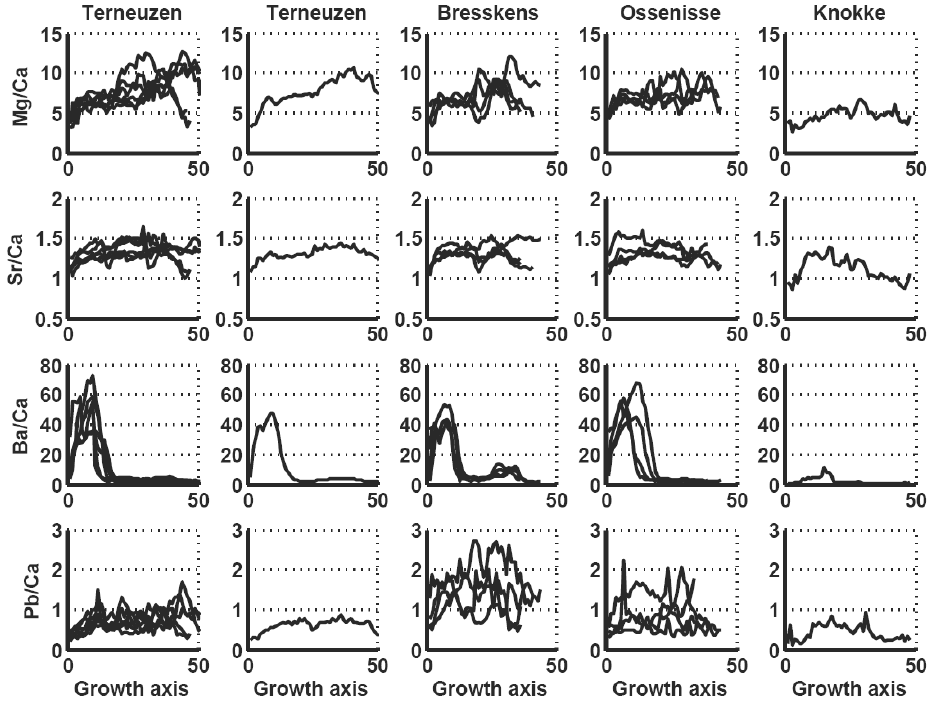
Fig. 3. Chemical signature along the growth axis of the shells used to train (first column) and to validate (columns 2 to 5) the models. The trace element/Ca ratios are in